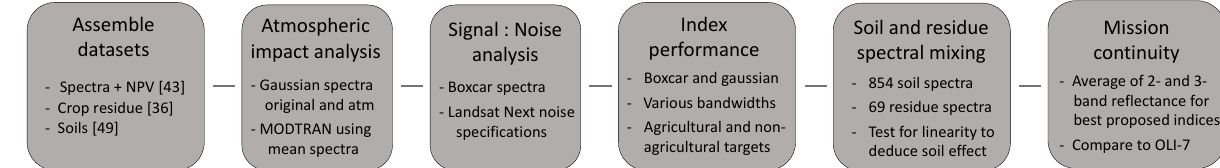
* using simulated Landsat 8 OLI bands 6 (1609 nm) and 7 (2201 nm). ** using simulated Landsat 8 OLI band 6 (1609 nm) and average of Landsat Next proposed bands 2100, 2210, and 2260.